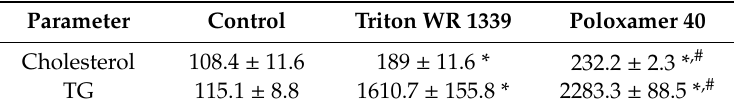
Table 1. Serum total-cholesterol and TG levels (mg / dl) in mice that received either Triton WR 1339 (500 mg / kg, i.p., single dose) or poloxamer 407 in the same dose and mode of administration (M ± m, N =